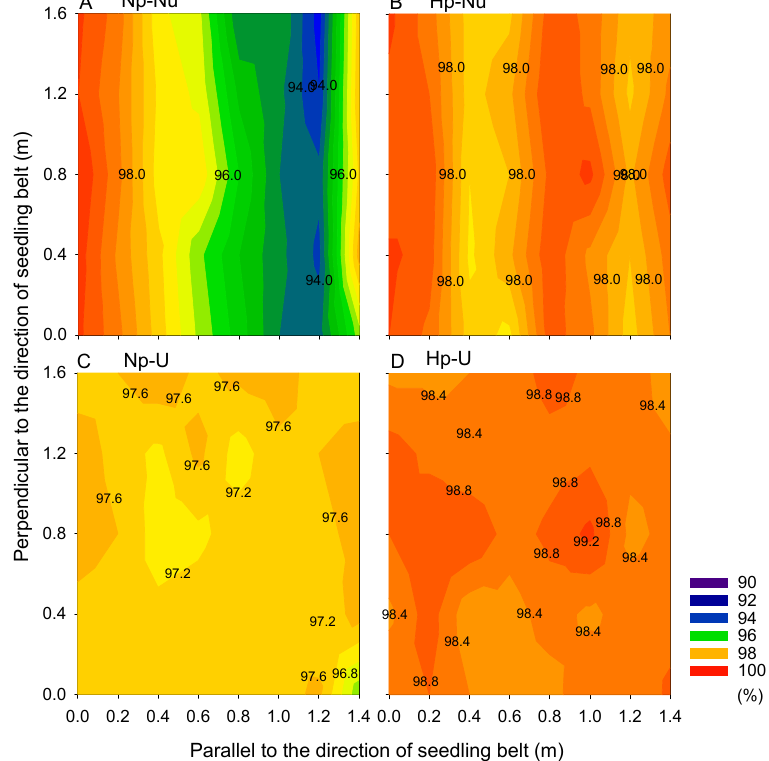
Figure 7. Effect of plant distribution on canopy light interception rate of soybean under different planting densities. ( A – D ), the canopy light interception rate under Np-Nu, Hp-Nu, Np-U, and Hp-U treatments, respectively. Np, normal seeding density. Hp, high seeding density. Nu, non-uniform plant distribution. U, uniform plant distribution. The change from dark blue to deep red indicates that the canopy light interception rate gradually increases. The number represents the value of canopy light interception rate on the contour line.